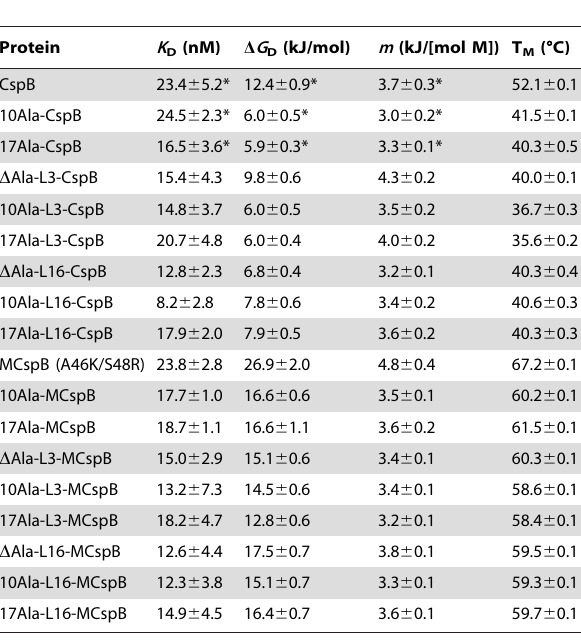
Table 1. K D values upon dT7 binding and thermodynamic parameters of CspB.